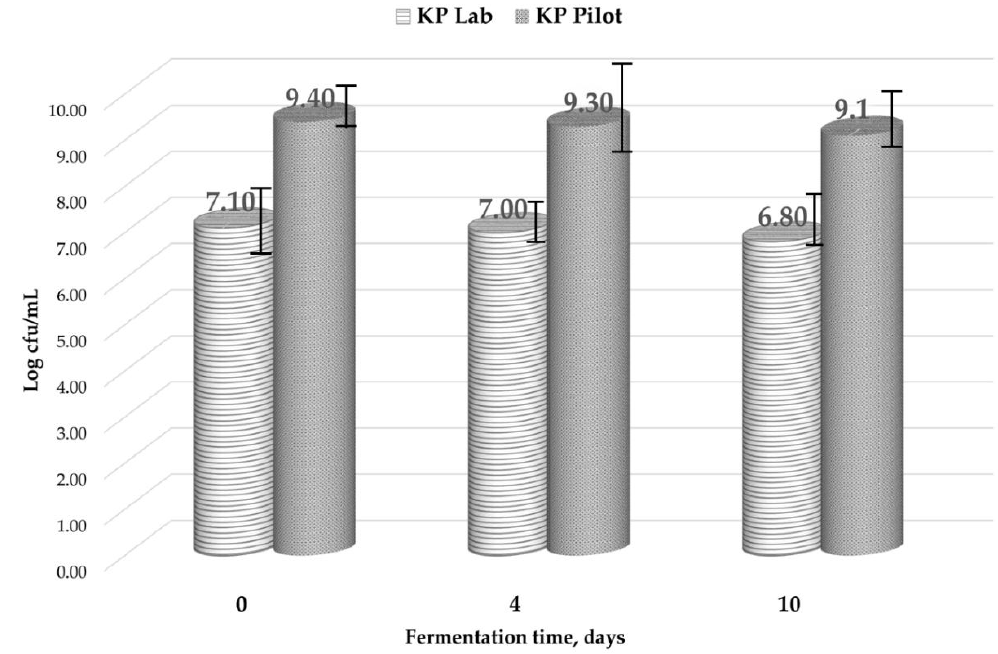
Figure 4. Lactic acid bacteria level during the fermentation process of Kombucha with pollen. Laboratory (Lab) versus Pilot Plant (Pilot) scale.